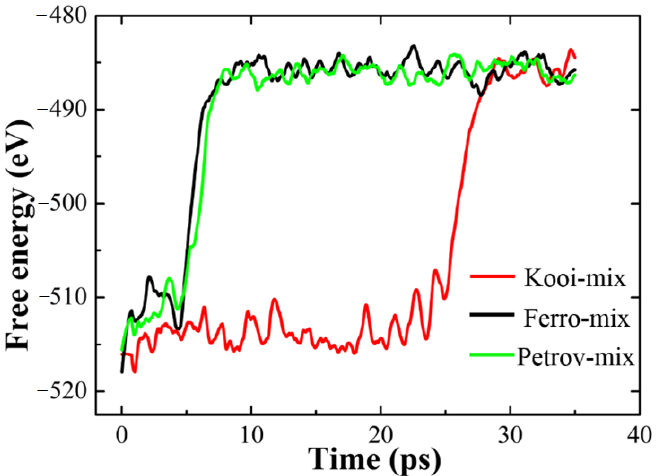
Figure 2. Free energy variations of the three GST-SL models during the melting process at 1400 K.